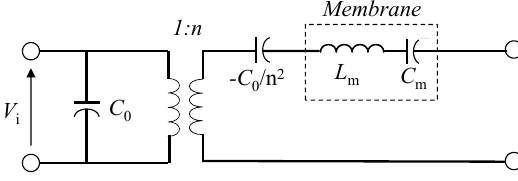
Figure 2. Electrical equivalent circuit model of